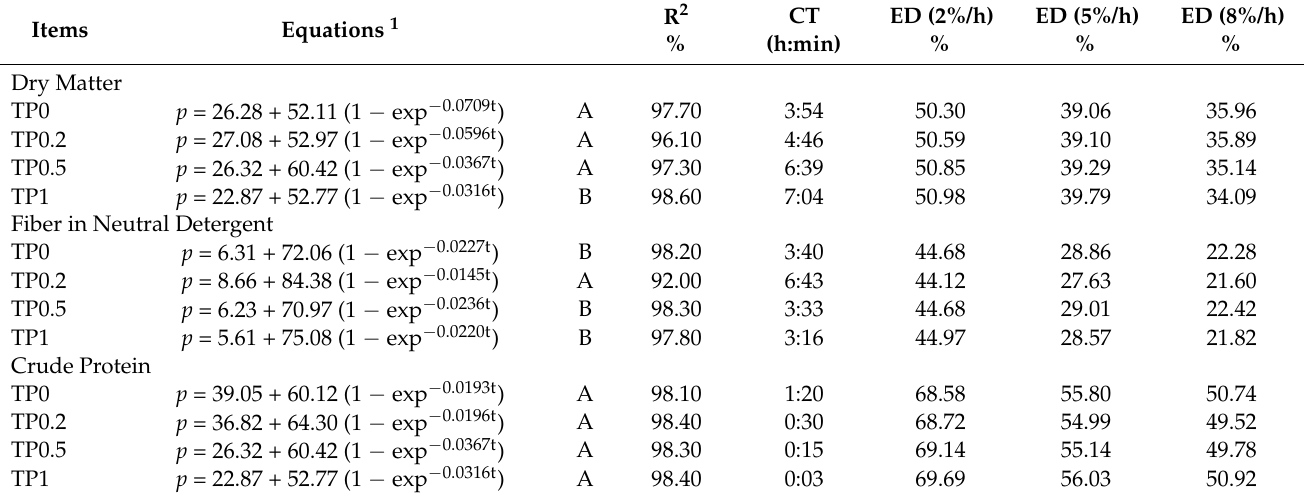
Table 6. Equations for ruminal degradation, colonization time (CT) and effective degradability (ED) of dry matter (DM), fiber in neutral detergent (NDF) and crude protein (CP) of palm kernel cake by buffaloes in the eastern Amazon.